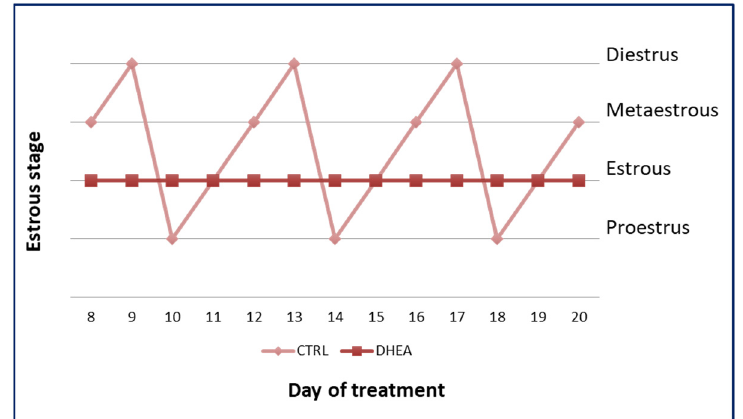
Figure 1. Estrous cycle in control and DHEA mice.